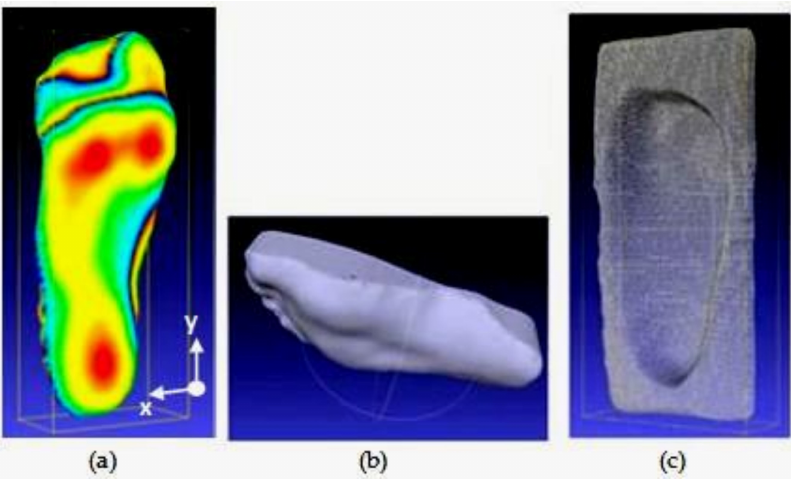
Figure 2. Example outputs of 3D scanning: ( a ) footprint depth in difference of colors; ( b ) 3D foam negative impression; ( c ) footprint 3D positive